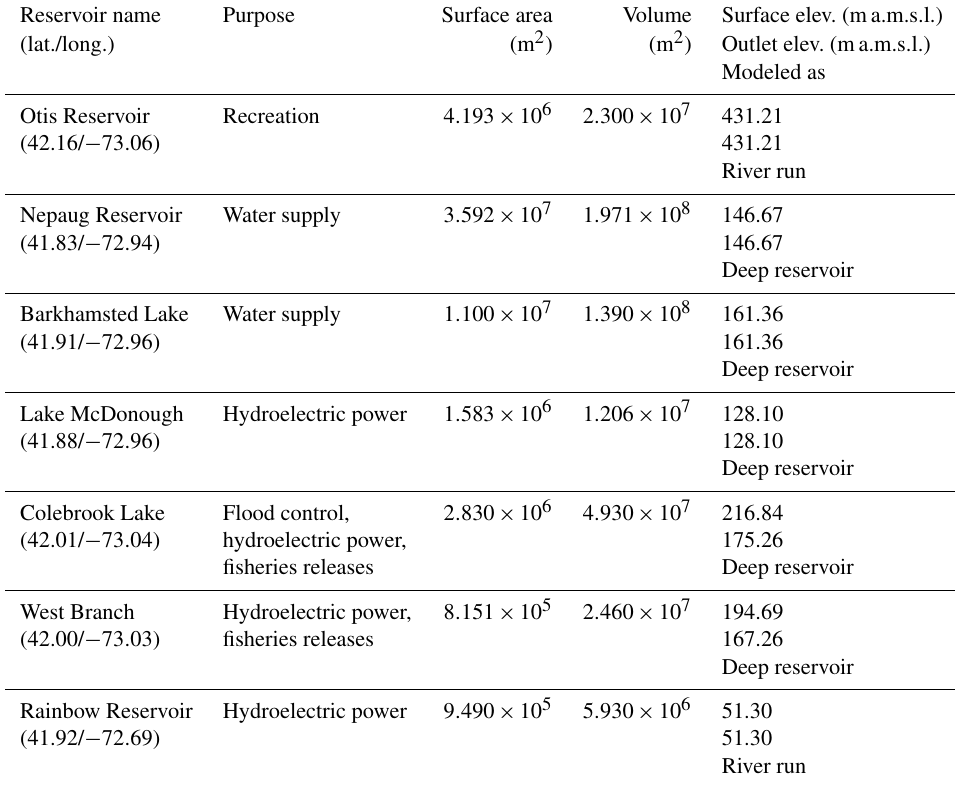
Table 1. Water storage projects in the Farmington River basin modeled with one-dimensional (river run) or two-dimensional (deep reservoir) modules of RBM (ma.m.s.l. indicates meters above mean sea